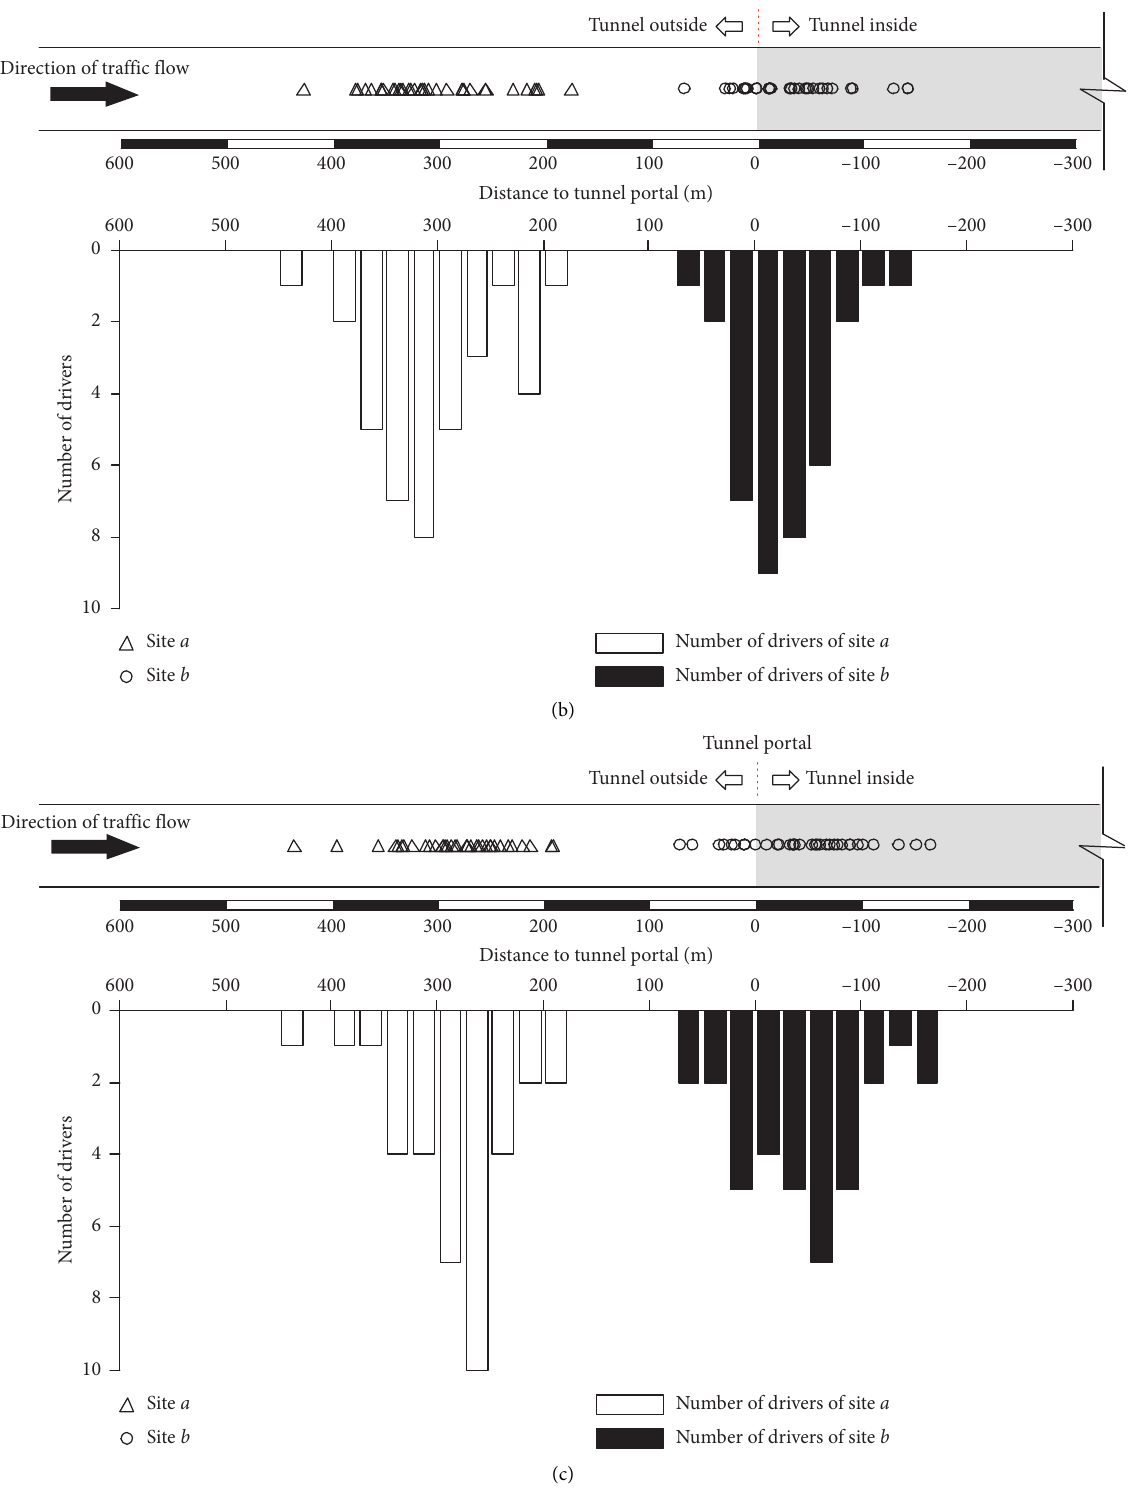
Figure 6: Localization of drivers’ deceleration positions. (a) Short-tunnel condition, (b) medium-tunnel condition, and (c) long-tunnel